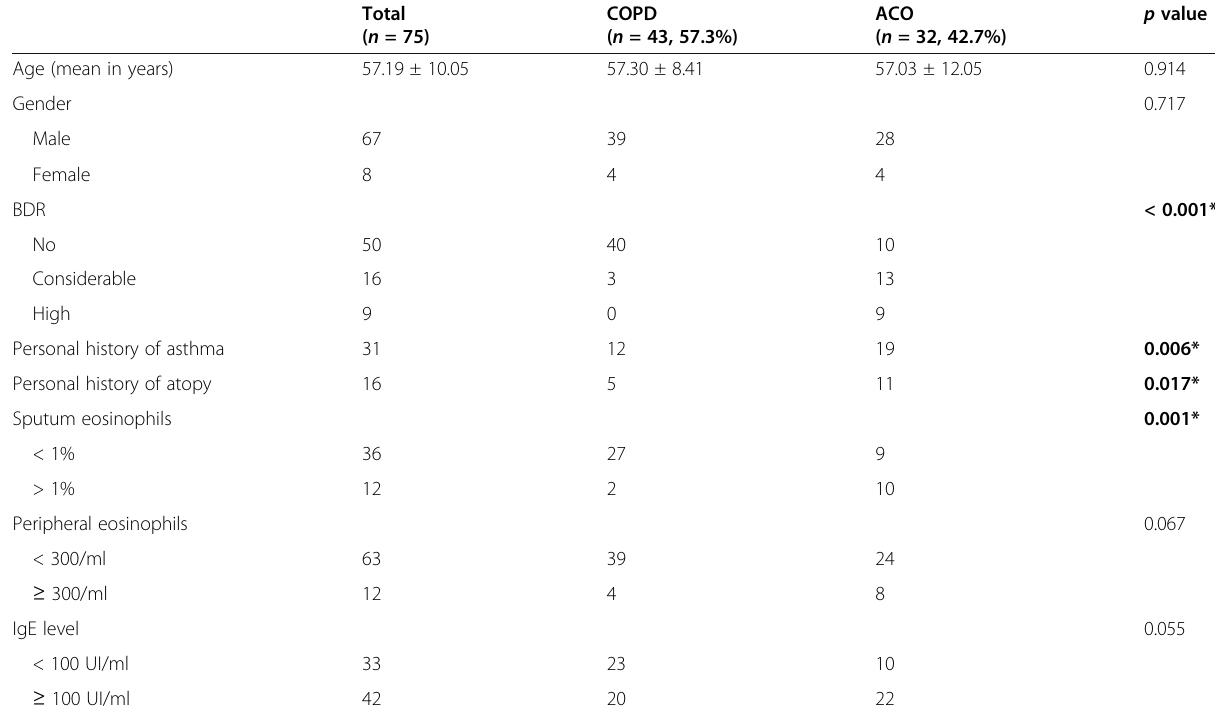
Table 2 Patients characteristics in group